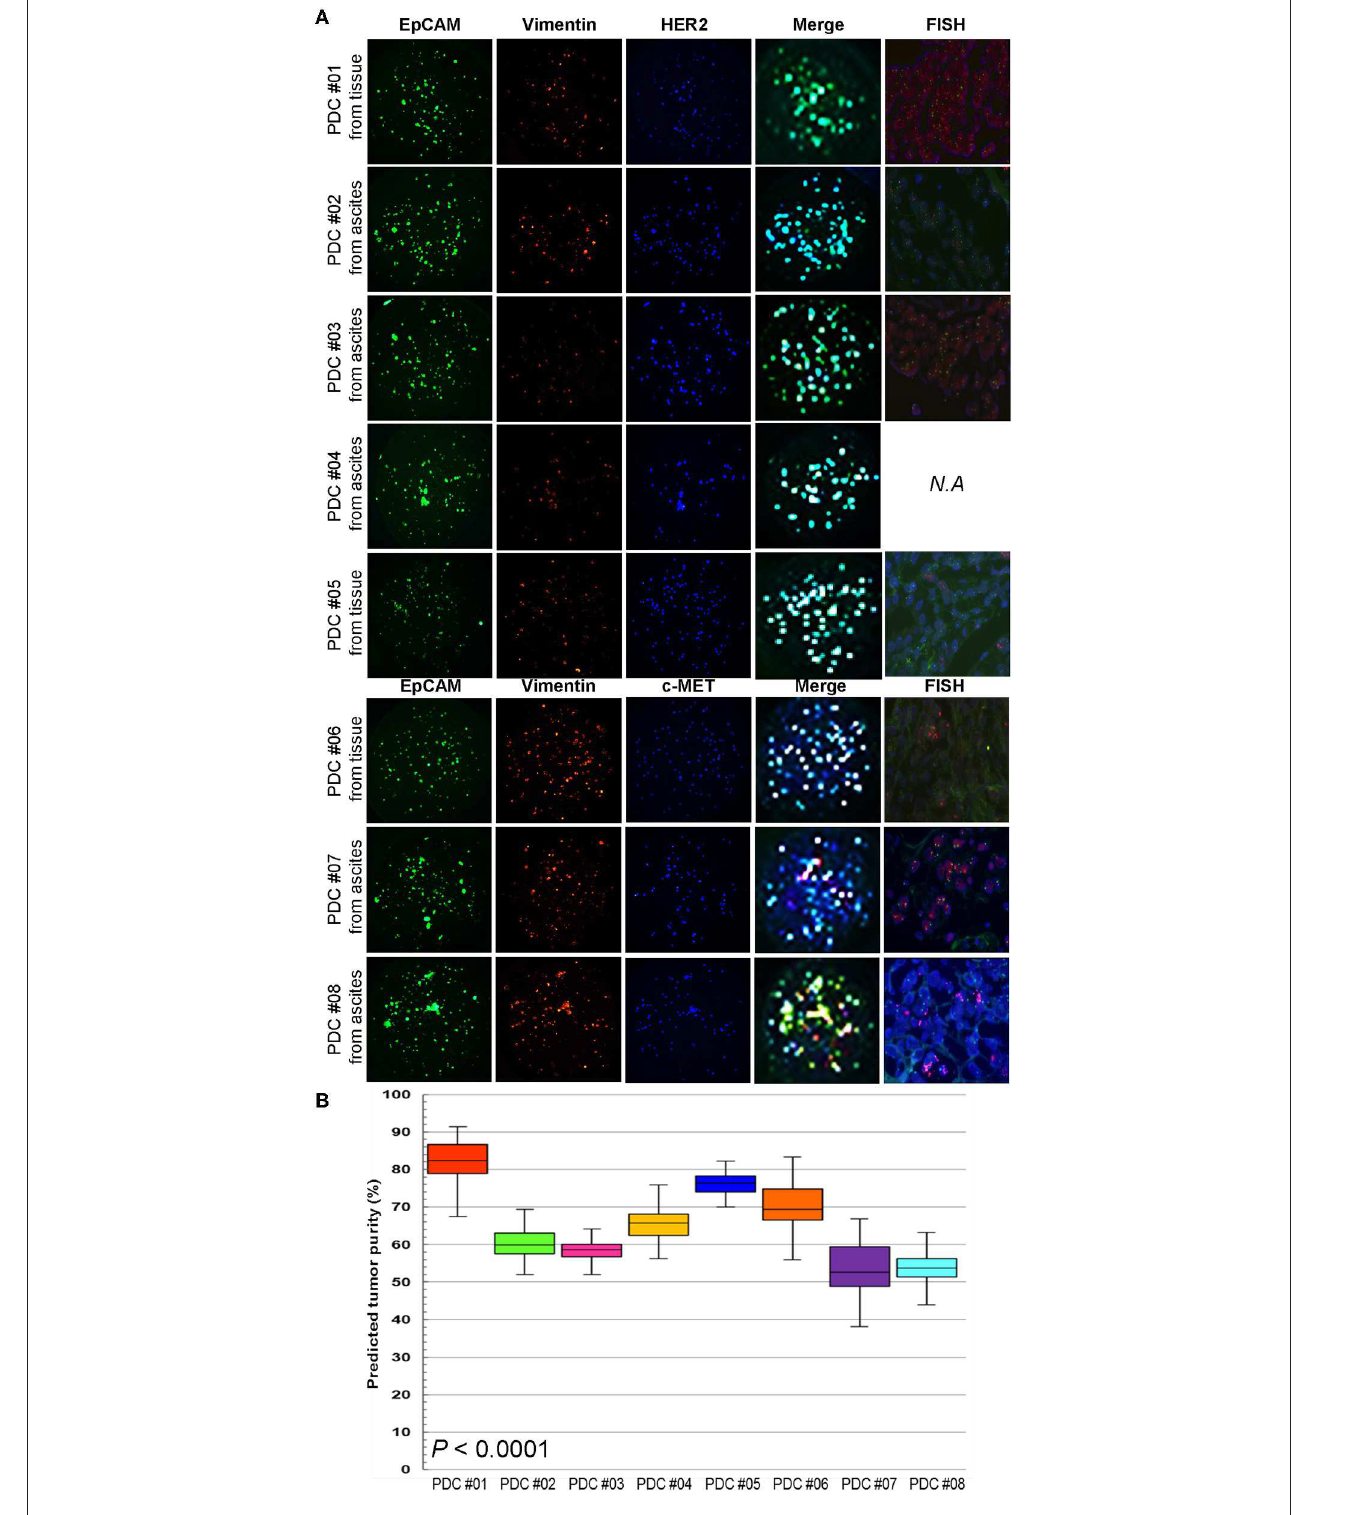
FIGURE 3 | Multi-channel immunofluorescence images of PDCs from 8 gastric cancer patients (A) EpCAM, vimentin staining, and merge images for predicting tumor purity in PDCs. The green color shows cancer cell staining and red color is the fibroblast signal. Addition of target oncogene staining to detect HER2 and MET expression in PDCs. The blue color shows HER2 expression in PDC #01-05 and MET expression in PDC #06-08. (B) Actual tumor purity and predicted tumor purity.